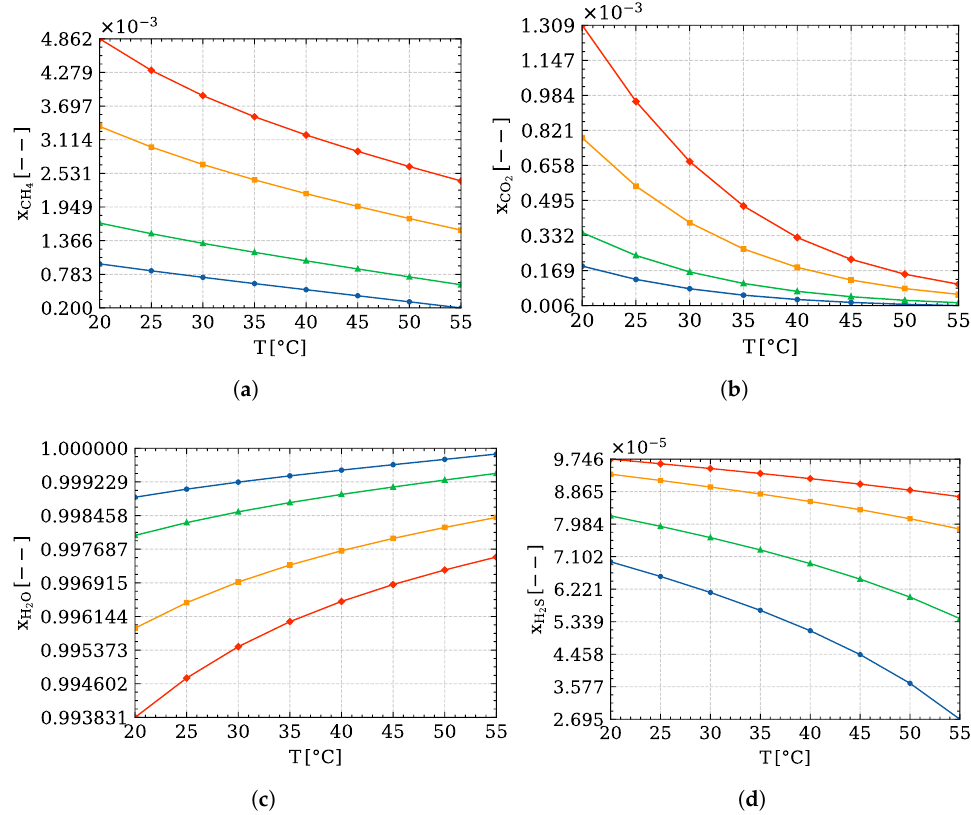
Figure 5. Trends of the liquid phase composition with respect to temperature and pressure of: ( a ) CH 4 , ( b ) CO 2 , ( c ) H 2 O, ( d ) H 2 S, evaluated through Equation (11);